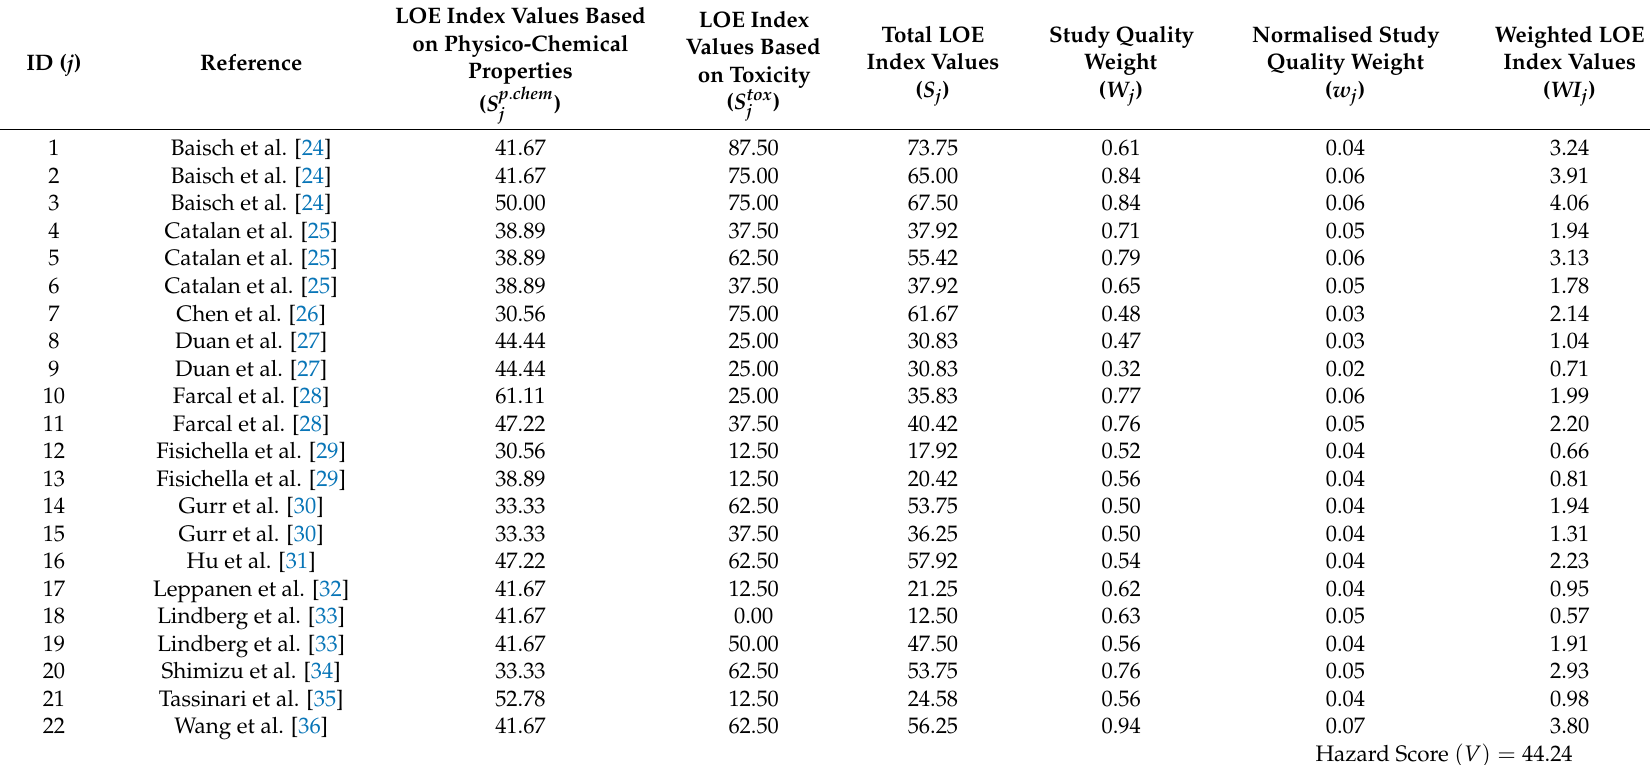
Table 1. Quantitative weight of evidence (WoE) results for nano-TiO 2 . Each line of evidence (LOE) represents experimental evidence from academic literature evaluated based on physico-chemical properties, toxicity, and study quality. The overall hazard of nano-TiO 2 ( V ) is derived from sum of all LOE-specific hazard scores ( WI j